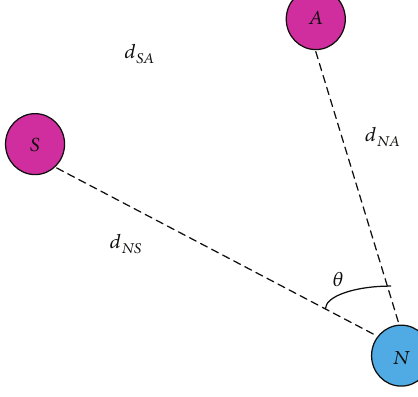
Figure 5: Individual neighbor angle.